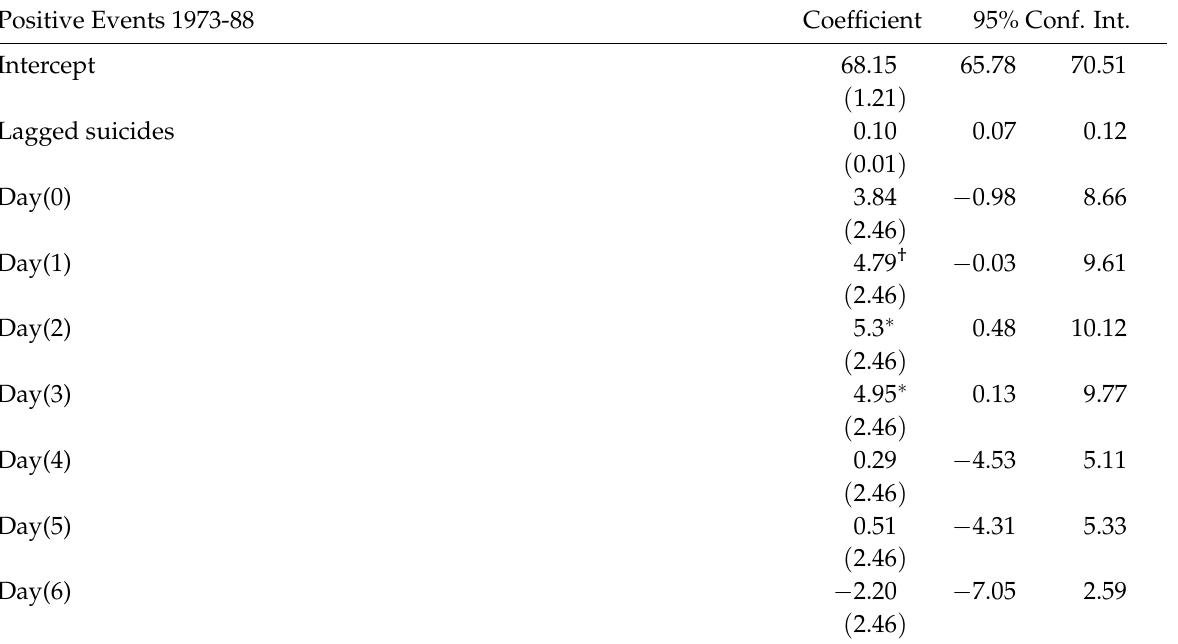
Table 4: The effect of positive exceptional events on daily suicide, 1973-1988 Positive Events